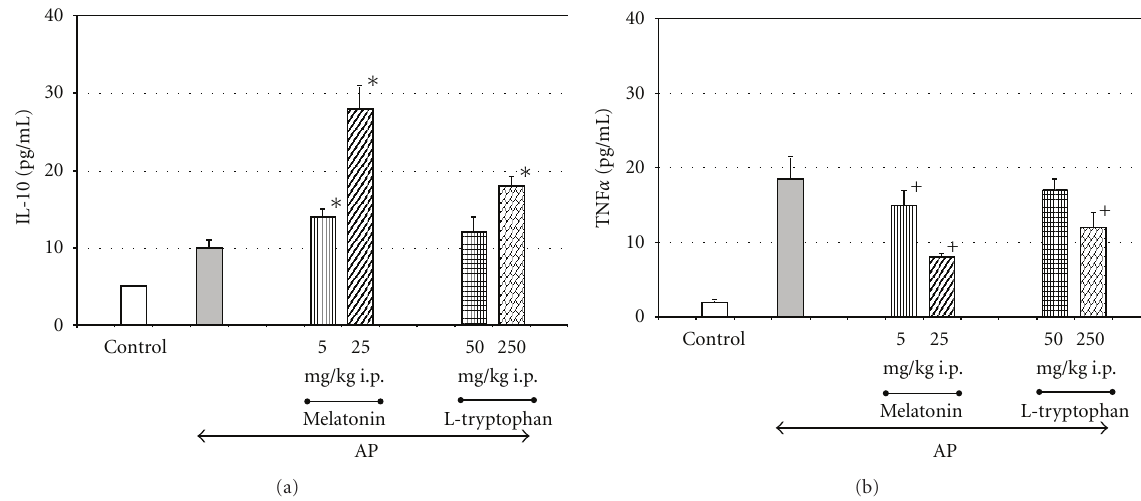
Figure 1: E ff ect of melatonin on plasma levels of interleukin 10 (IL-10) and tumor necrosis factor α (TNF α ) in the rats with acute pancreatitis (AP). Melatonin or its precursor, L-tryptophan, was given to the rats 30min prior the induction of acute pancreatitis produced by caerulein overstimulation (5 μ g/kg-h × 5h). Control-intact rats. Means ± SEM from the separate experiments, each performed on 8–10 rats. Asterisk indicates significant increase above the value detected in AP rats alone. Cross indicates significant decreases below the value detected in AP rats